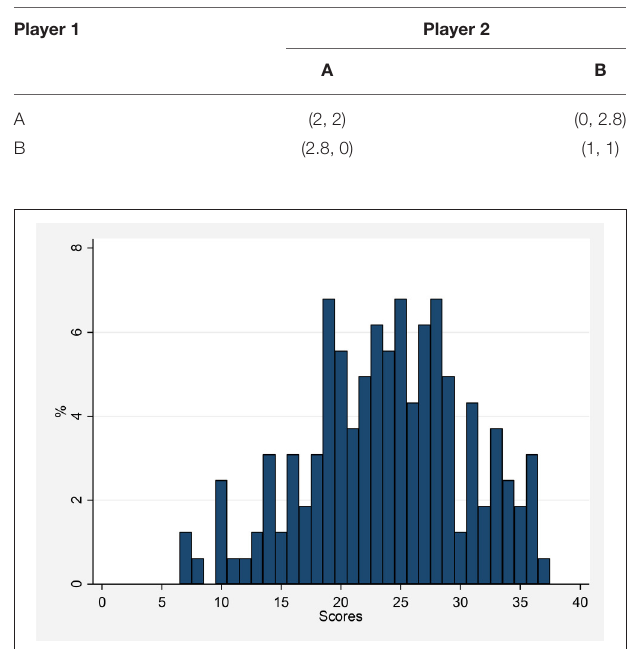
FIGURE 1 | Scores observed in the DAT-AR